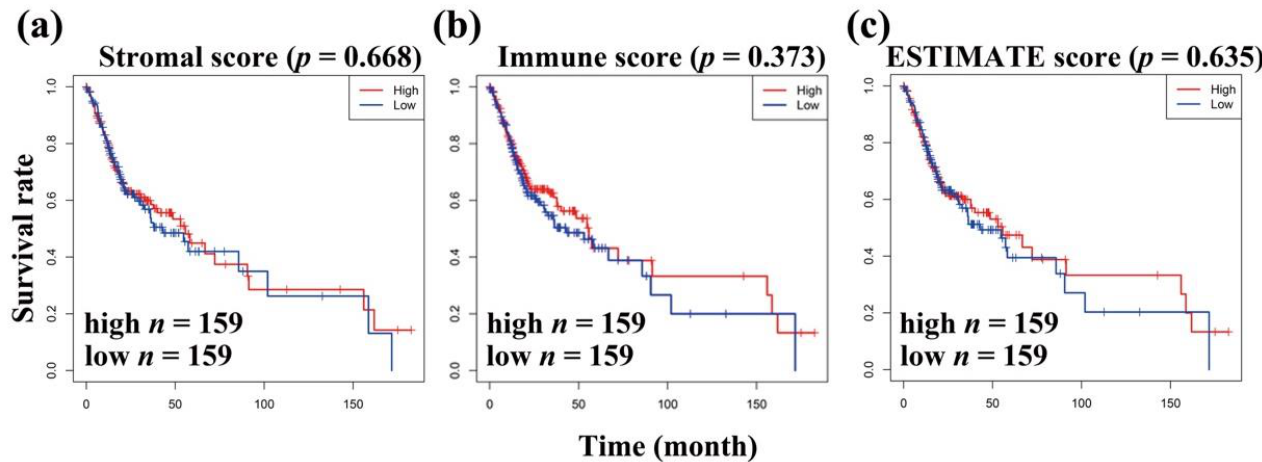
Figure 1. The relationship between stromal/immune/ESTIMATE scores and survival rate of OSCC patients. ( a ) KM survival analysis of OSCC patients based on their stromal scores. ( b ) KM survival analysis of OSCC patients based on their immune scores. ( c ) KM survival analysis of OSCC patients based on their ESTIMATE scores. Red line represents the survival curve of OSCC patients with higher values of stromal scores, immune scores, and ESTIMATE scores ( n = 159). Blue line represents the survival curve of OSCC patients with lower values of stromal scores, immune scores, and ESTIMATE scores ( n = 159).